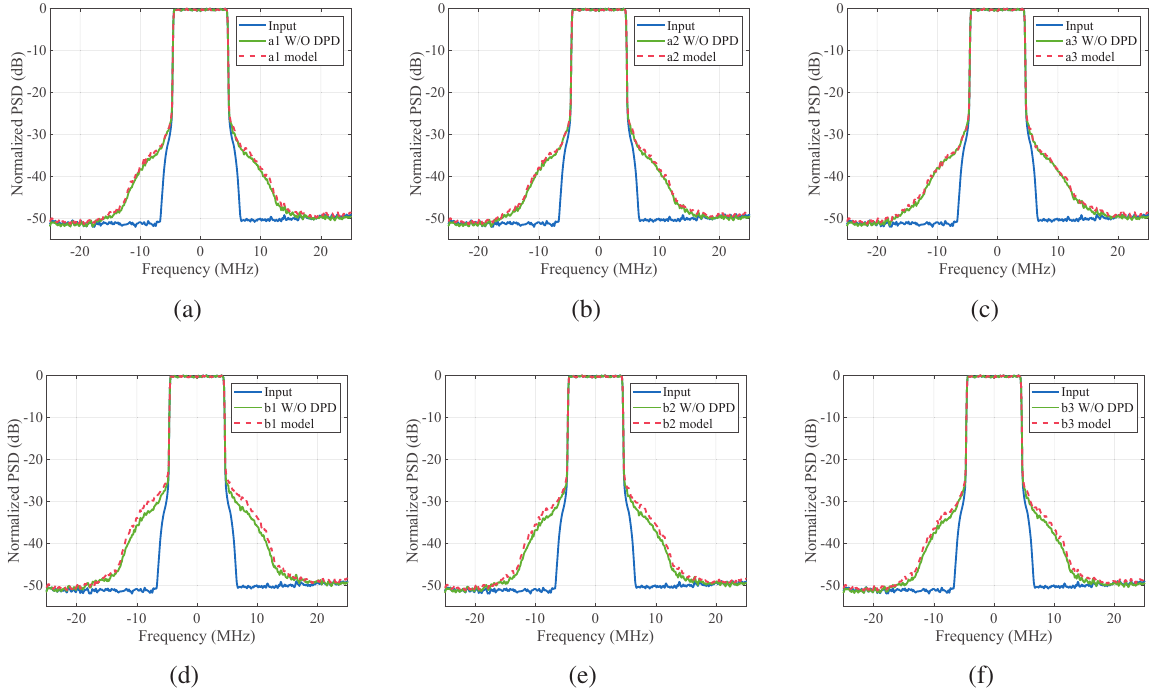
Figure 7. Simulated results of the output PSDs. Group A: ( a ) mode a1, ( b ) mode a2, and ( c ) mode a3. Group B: ( d ) mode b1, ( e ) mode b2, and ( f ) mode